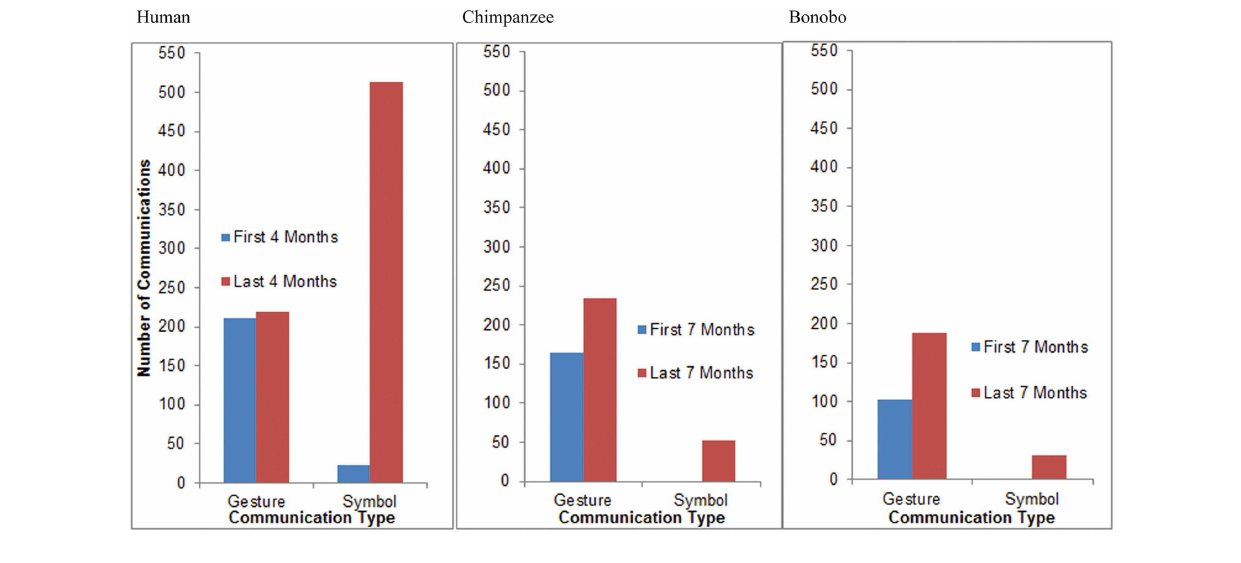
FIGURE 11 |A cross-species comparison of the frequency of communicative gestures relative to symbols during the first and the second half of the study. (The bonobo produced two lexigrams in the first